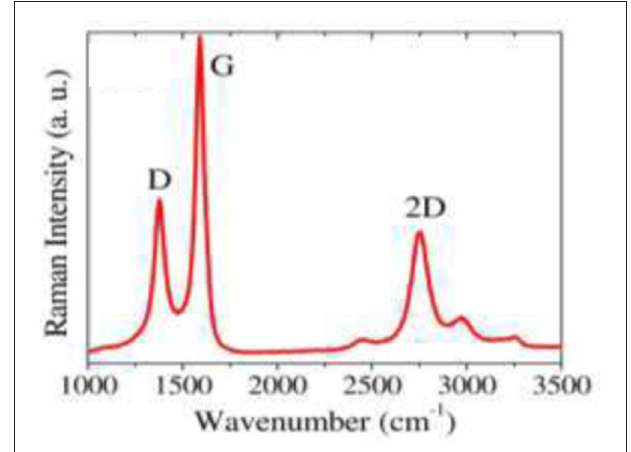
FIGURE 8 | Raman spectrum at 442nm of Ni/a-C(20nm)/Si after thermal annealing at 780 ◦ C ([Reproduced from Tite et al. (2014) with permission of AlP Publishing].